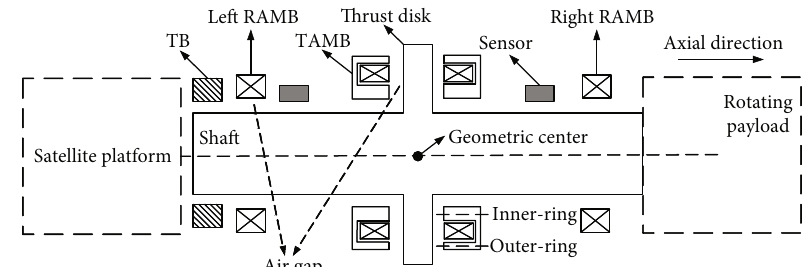
Figure 2: Structure of the AMB subsystem.